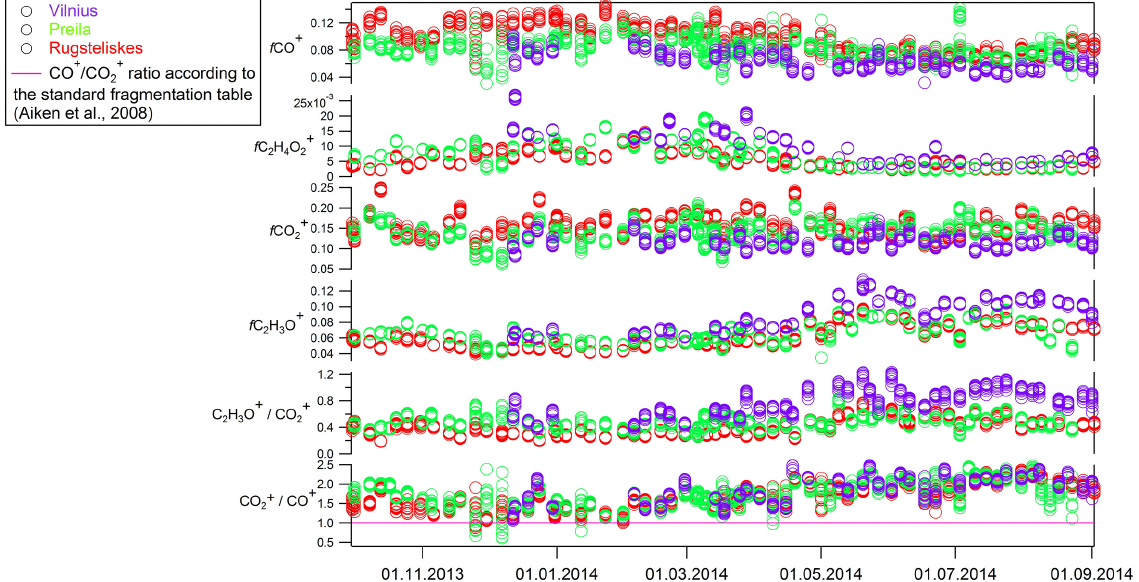
Figure 8. Time-dependent fractional contributions ( f ) of typical AMS